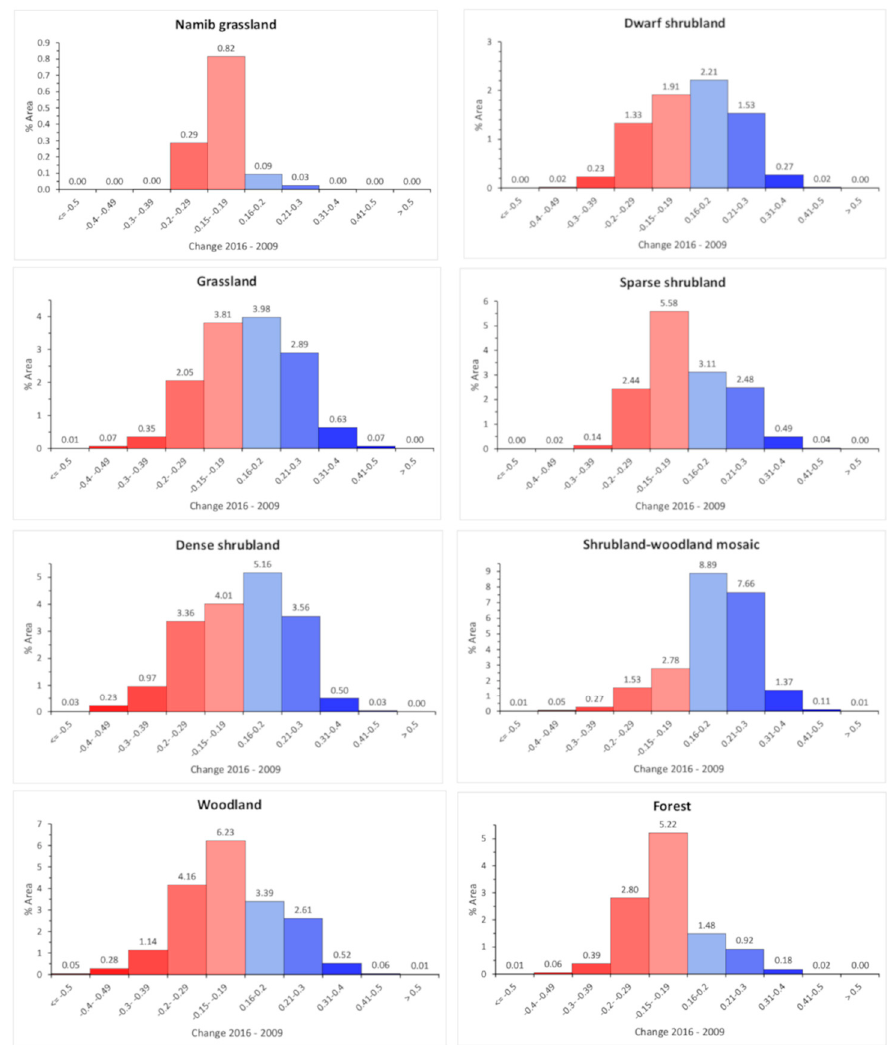
Figure 11. Changes in fractional woody cover between 2016 and 2009 for each vegetation structural class. Changes of less than 0.15 fractional woody cover were excluded as this was less than the average change uncertainty, σ FWC Δ .